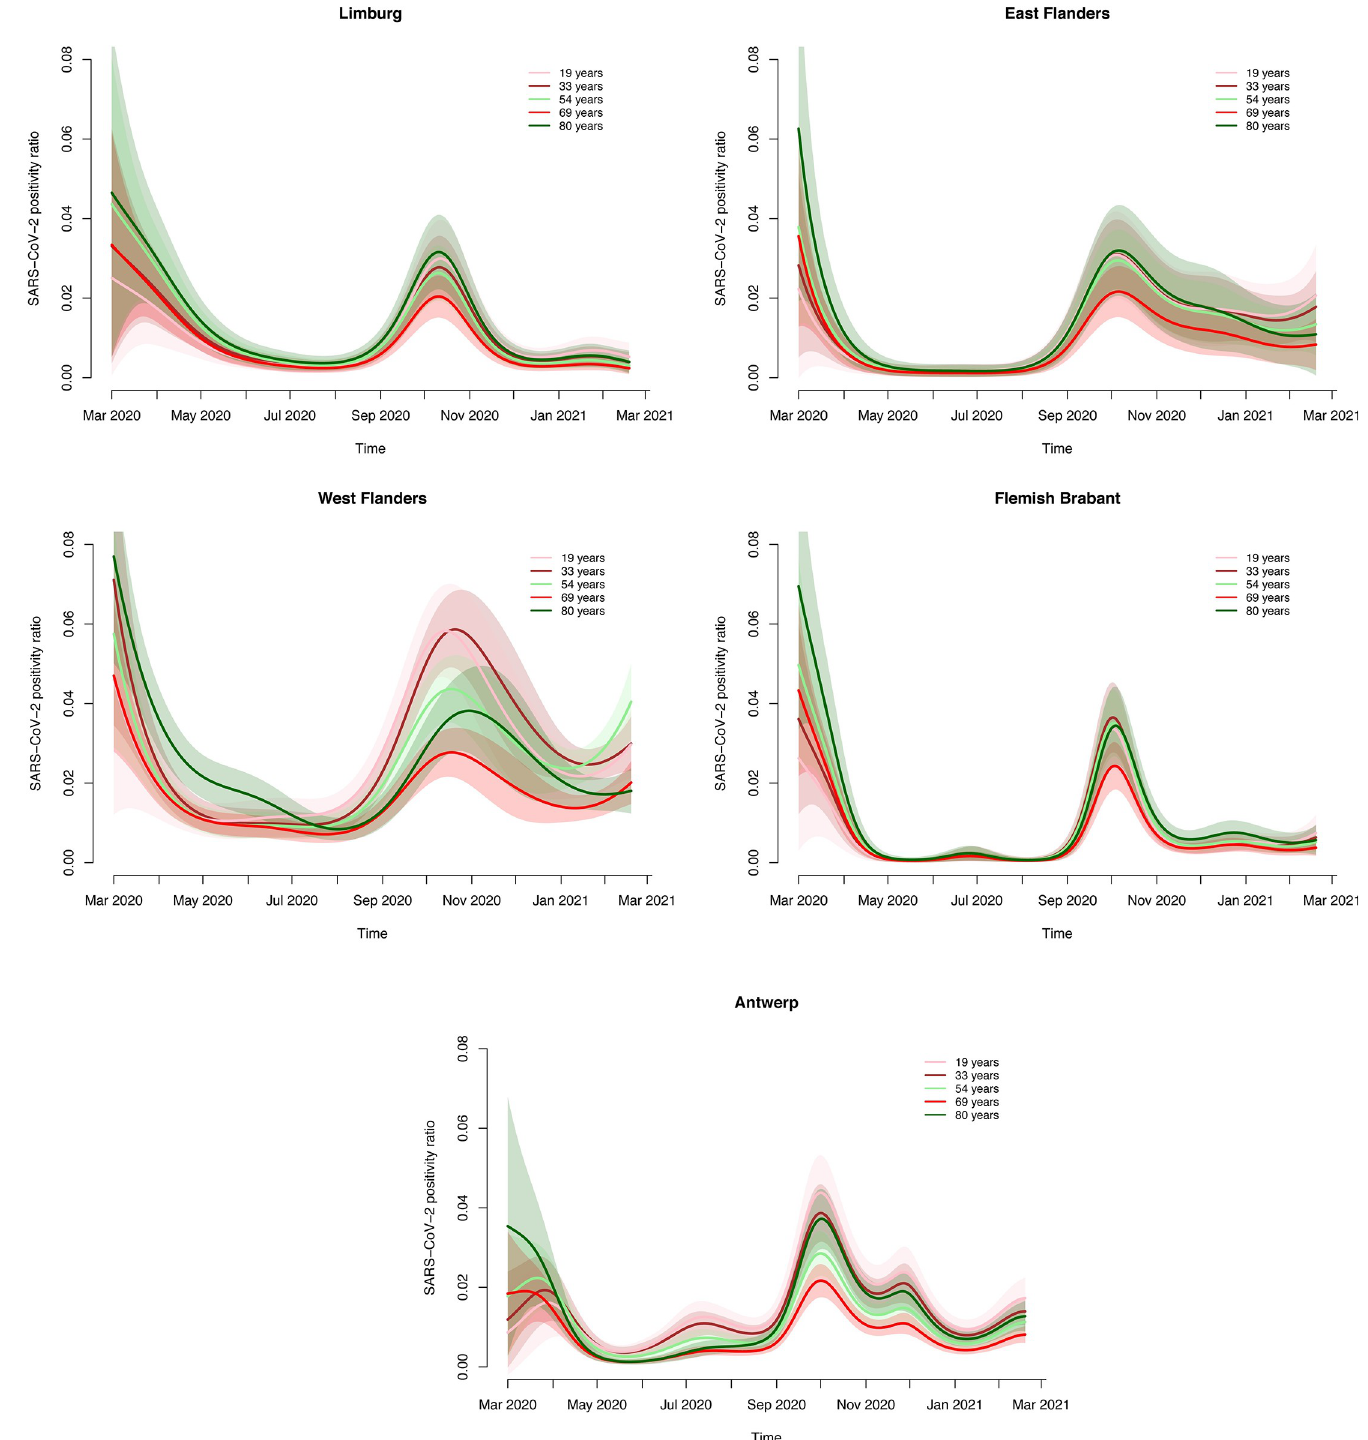
Fig 6. Estimated evolution of the SARS-CoV-2 real-time RT-PCR positivity ratio in a-/pre-symptomatic patients screened pre-hospitalization/pre-surgery by age (individuals aged 19 years, 33 years, 54 years, 69 years and 80 years) in Limburg (upper left panel, A), East Flanders (upper right panel, B), West Flanders (middle left panel, C), Flemish Brabant (middle right panel, D), Antwerp (lower panel, E) together with pointwise 95% confidence bounds (shaded areas).